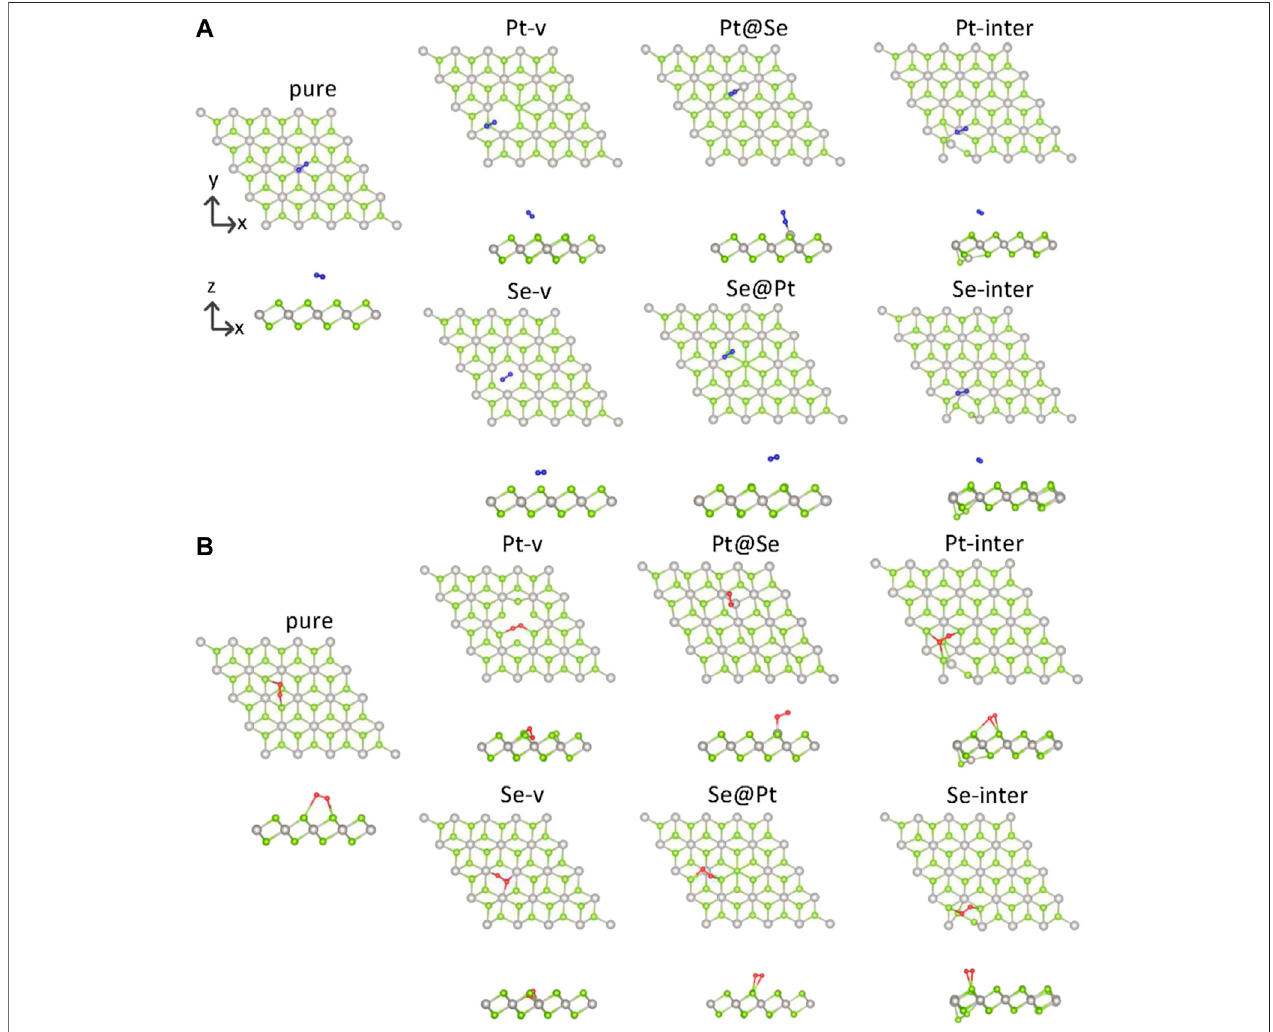
FIGURE 1 | Top and side views of the adsorption structures of N 2 (A) and O 2 (B) on pure and defected PtSe 2 . The green and gray balls indicate Se and Pt atoms, respectively.